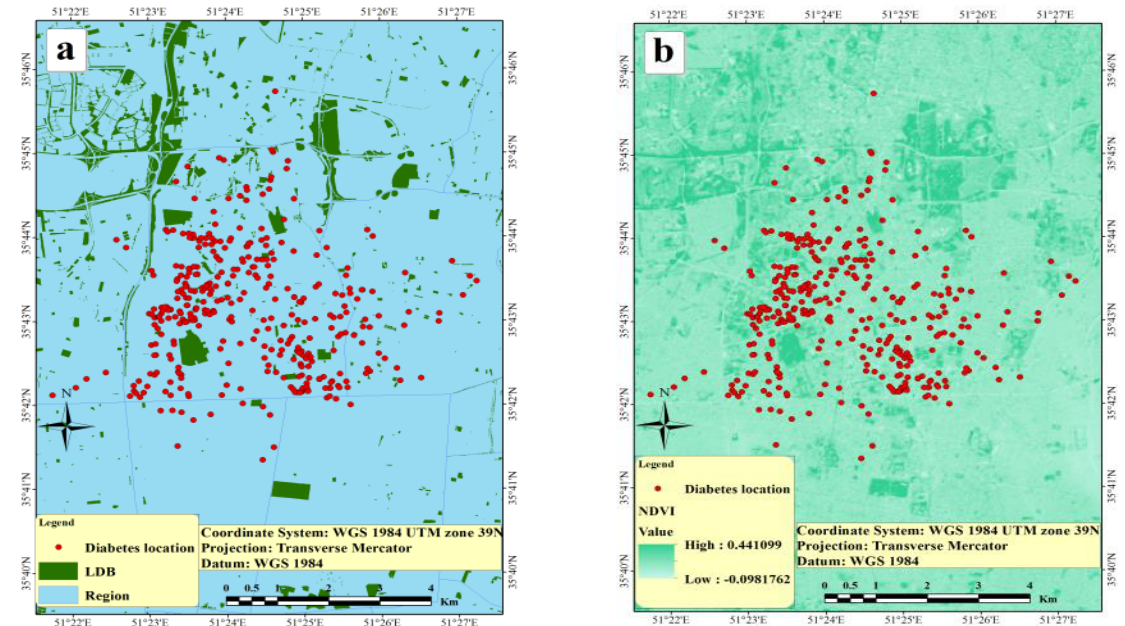
Figure 1. Distribution of T2DM in a) LDB and b) NDVI